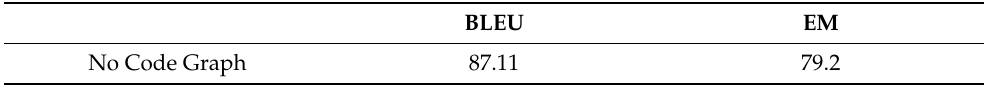
Table 6. BLEU and EM scores without code graph.